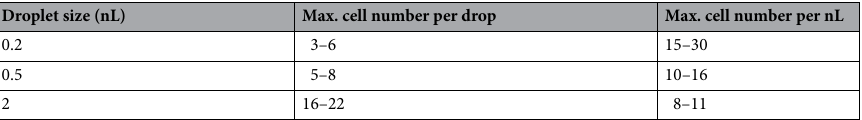
Table 4. Maximum cell numbers reached in droplet cultivation. Overview of maximum cell number (cells per drop) reached in the three drop sizes and the respective cell volume densities (cells per volume).